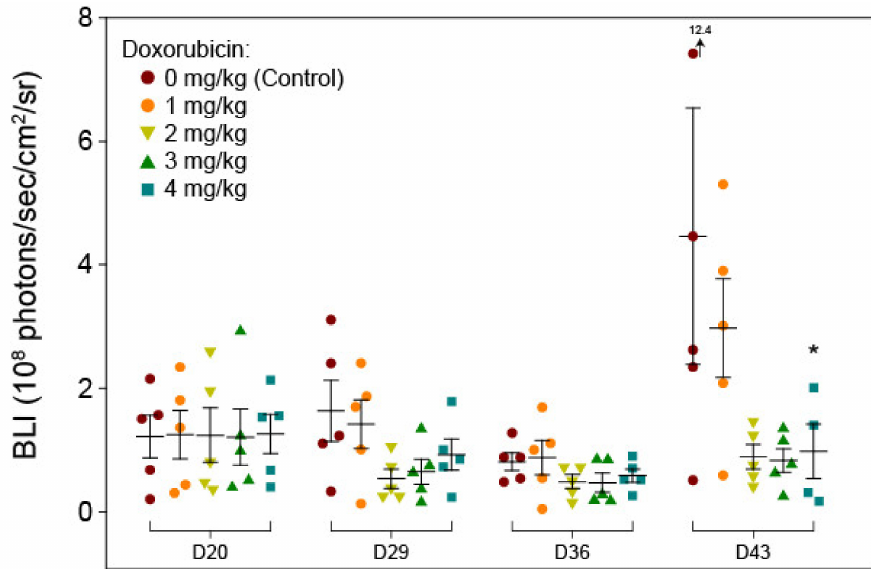
Figure 2. ID50 determination via quantification of bioluminescence imaging data (measured on the days 20, 29, 36, and 43 after tumor cell injection). Symbols represent data from individual mice in the various treatment groups ( n = 5 per group). Doxorubicin was injected intraperitoneally without a capnoperitoneum on days 21, 28, 25, and 42. Horizontal bars and whiskers represent the means and standard errors of the mean, respectively. *, in the 4 mg / kg body weight group, one mouse died after the last injection (before imaging) and a second mouse in this group died before autopsy. D,